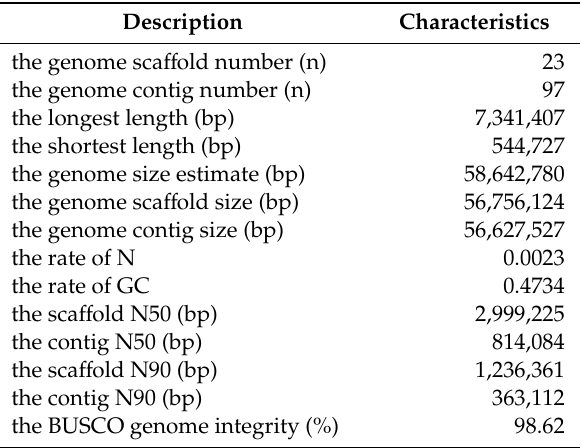
Table 1. Genomic characteristics of M.